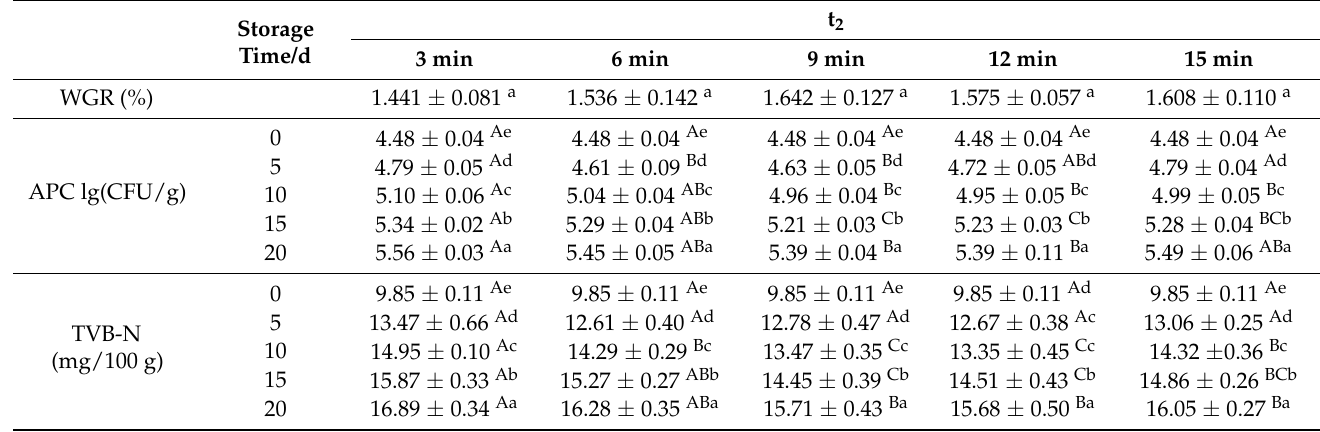
Table 6. Changes in WGR, APC, and TVB-N of tilapia fillets under different t 2 with fixed p v and t 1